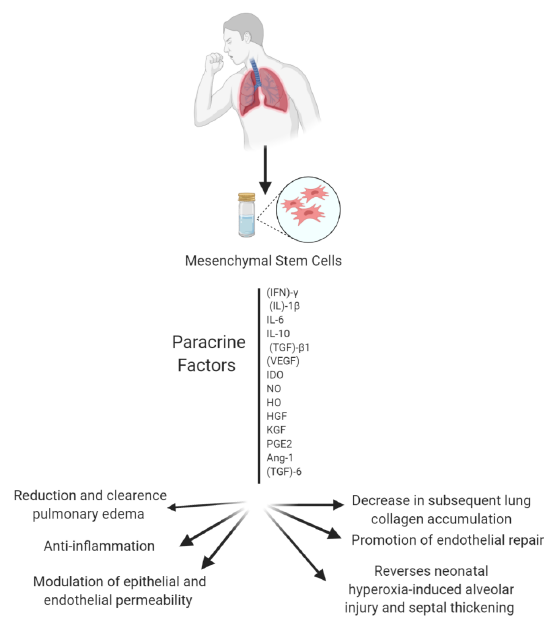
Figure 3. Overview of the several paracrine factors secreted by MSCs that can attenuate lung injury. Note: Figure created with